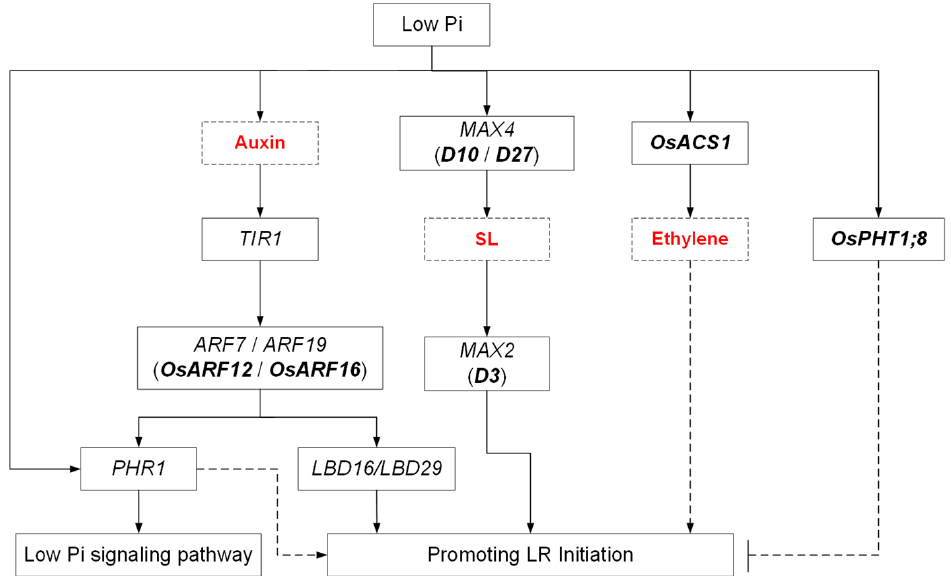
Figure 2. A working model of the molecular mechanisms underlying Pi starvation-induced LR growth in Arabidopsis and rice. Arrows with solid lines indicate a promotion, dashed arrows represent unconfirmed events, and blunt arrows represent negative regulation. Names in bold represent genes from rice. The hormones are highlighted in red.